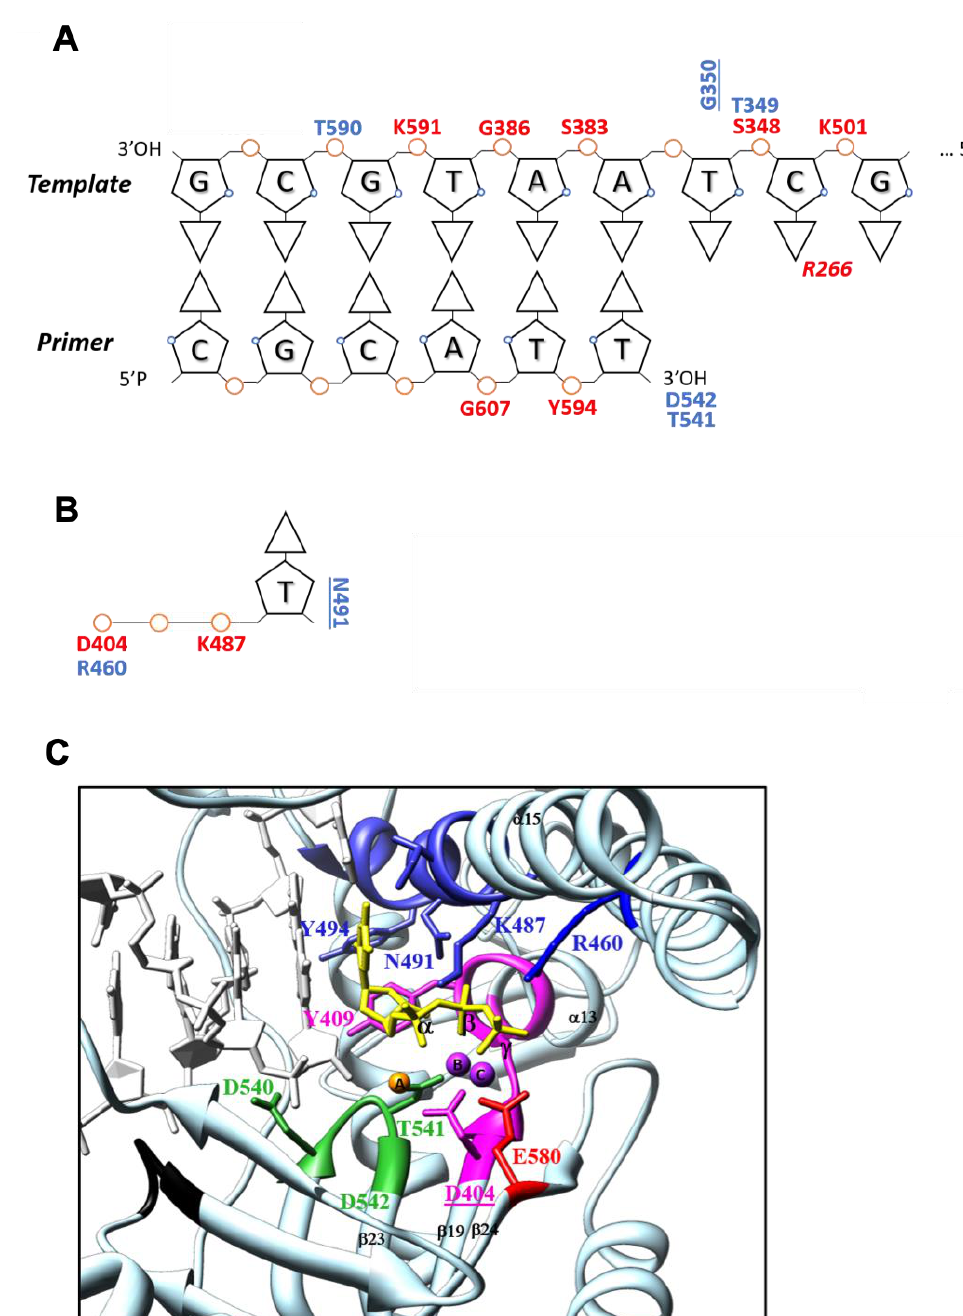
Figure 4. TgoT_6G12 active site analysis. ( A ) Pattern of interactions between TgoT_6G12 polymerase and the template/primer DNA duplex, in the binary complex, according to the strength of the interactions. The color code for the strength of interactions is: red for strong/moderate and direct interactions and blue for weak electrostatic but direct interactions. Interactions between the enzyme and the phosphate backbone of DNA are labeled above, for the template, and below, for the primer, each phosphate (represented by an orange circle). Interactions between the enzyme and the ribose moieties are labeled, underlined and vertical. Interactions between the polymerase and the nucleotide base are in italics. ( B ) Interactions of TgoT_6G12 with the ddTTP incoming nucleotide using the same labeling scheme. ( C ) TgoT_6G12 active site with the incoming ddTTP (colored in yellow). Representative sequence motifs are labeled. The Kx3NSxYGx2G B-motif in the finger domain is colored in dark blue. The A-motif (DxxSLYPSI) is colored in magenta and the catalytic residue D404 is underlined. The C-motif (DTDG) of the palm domain is colored in green and the KKKY motif of the thumb domain is colored in black. One other residue of the palm domain, which interacts with the